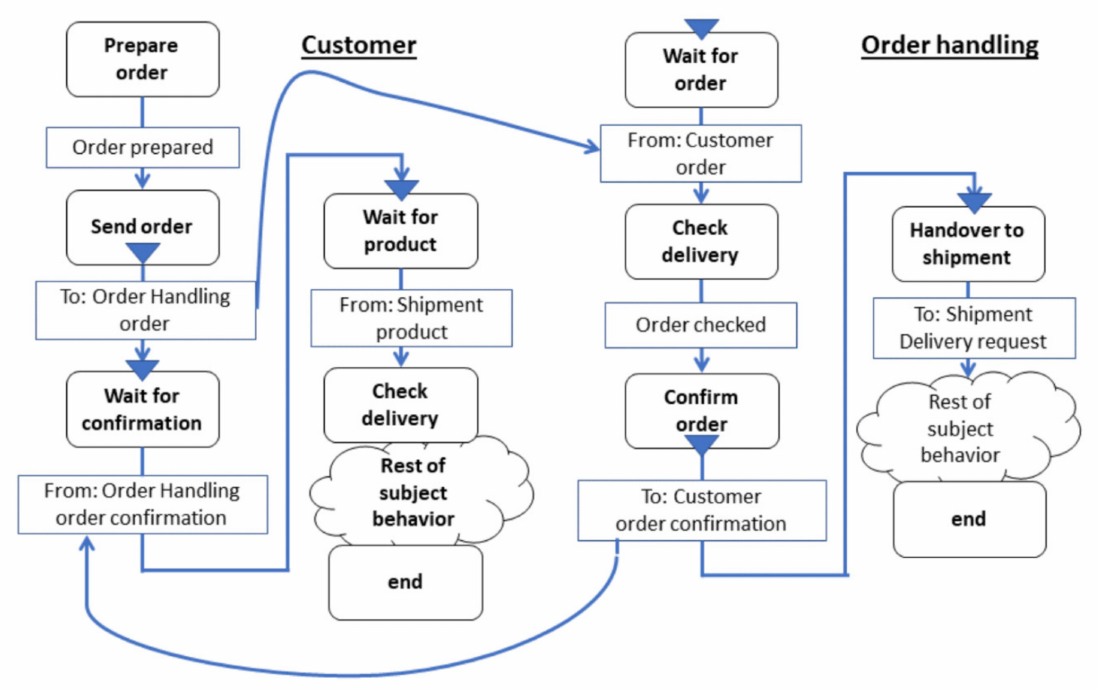
Figure 6. Order Handling—Subject Behavior Diagrams “Customer” and “Order